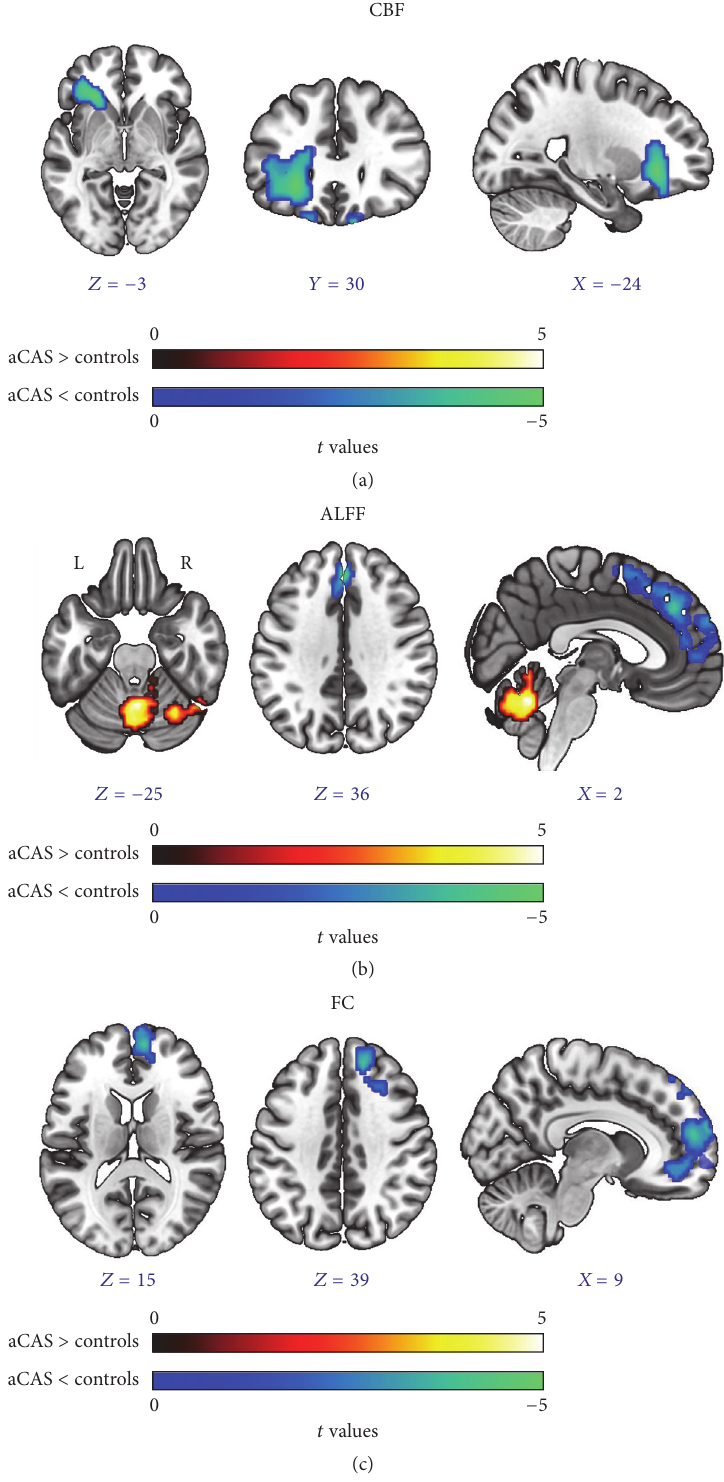
Figure 1: CBF, ALFF, and FC differences between two groups. (a) CBF differences between two groups. (b) Differences of ALFF between two groups. (c) FC differences between aCAS patients and controls. The color bar in (a), (b), and (c) represents 𝑡